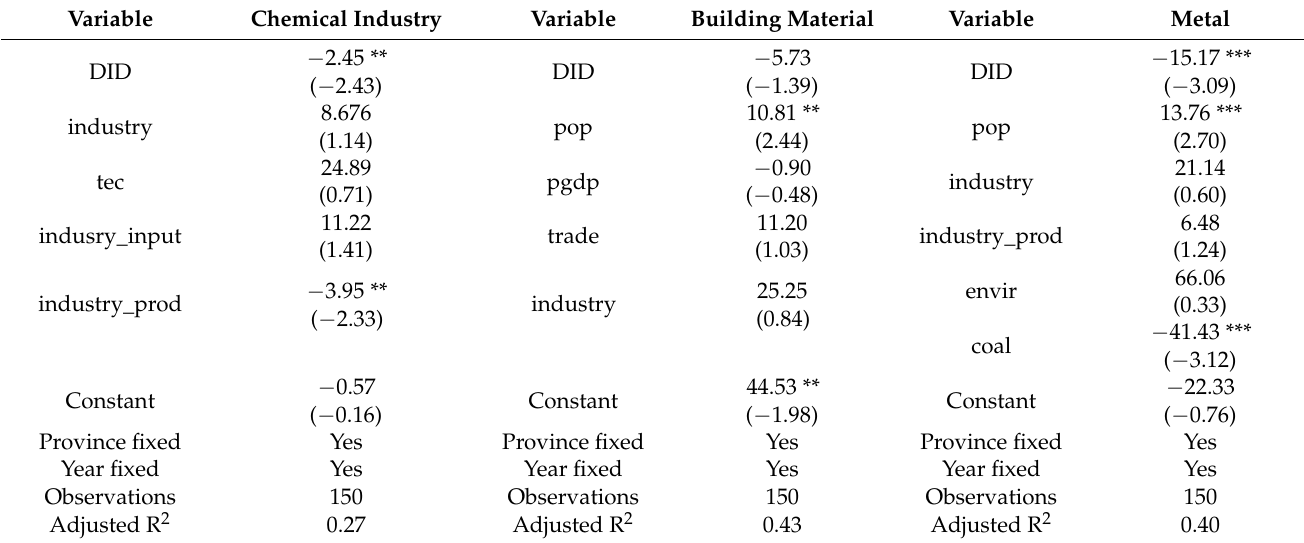
Table 3. Evaluation of consumption-based mitigation effects of carbon trading